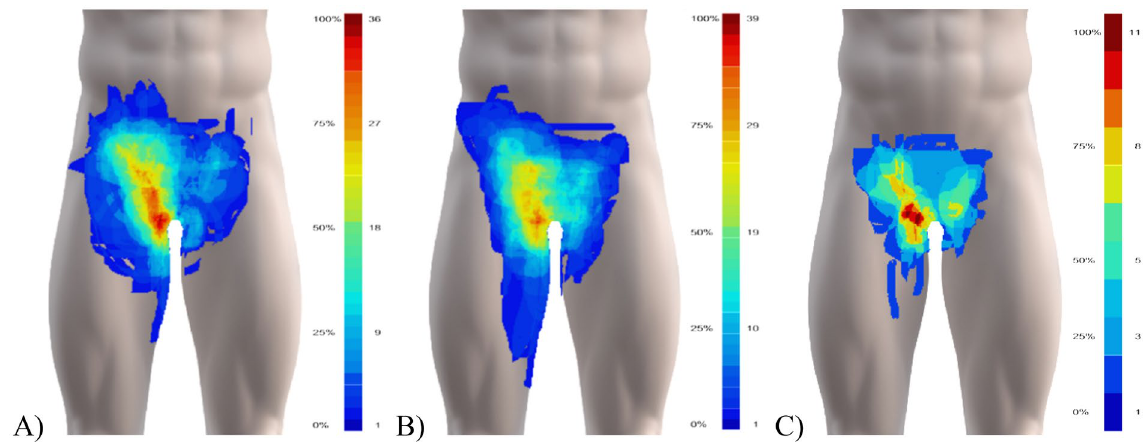
Figure 2. Pain map overlays from patients with ( A ) one (N = 88), ( B ) two (N = 64), and ( C ) three (N = 15) clinical entities of groin pain showing the overall spread and common regions. The colour-scheme range reflects the maximum overlap and the minimum one overlapping area, shown in percent and the absolute number of drawings. Areas drawn by only one individual are not shown in the summary figures. Before overlaying, unilateral left-sided pain drawings were flipped right, and bilateral pain drawings flipped, so the largest drawn area is on the right